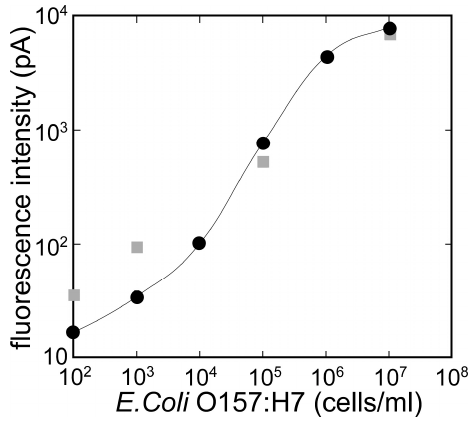
Figure 6. Calibration curve for E. coli O157:H7 in PBT (circle) and E. coli O157:H7 in milk (square).